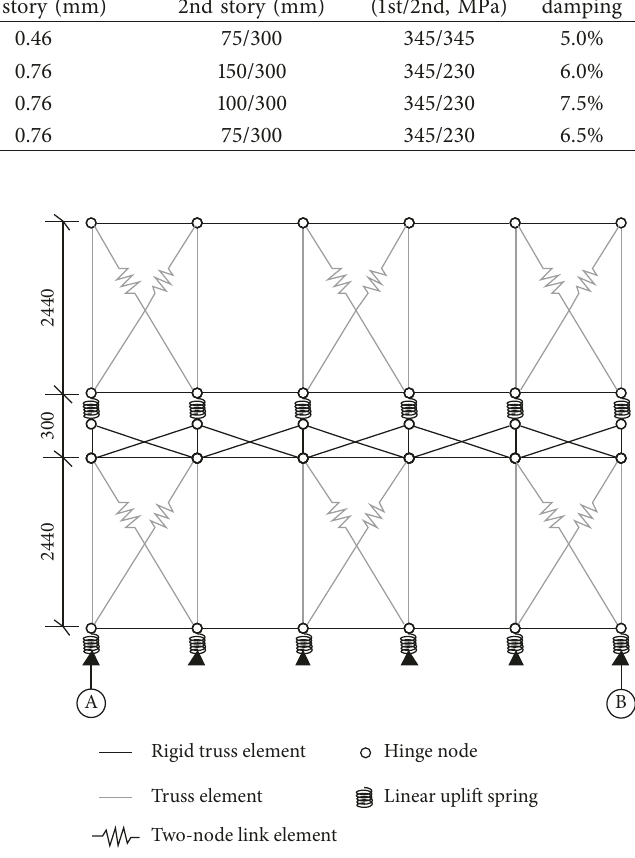
Figure 3: Analytic model of the walls from axial-A to